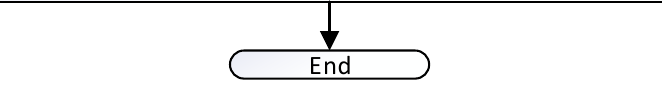
Figure 3. Flowchart about Algorithms 1 and